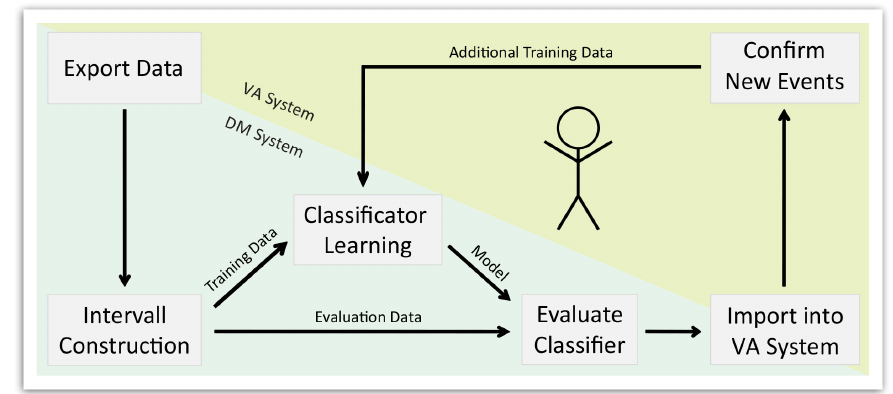
Figure 2. Workflow proposed by Janetzko et al. [2] for the semi-automatic detection